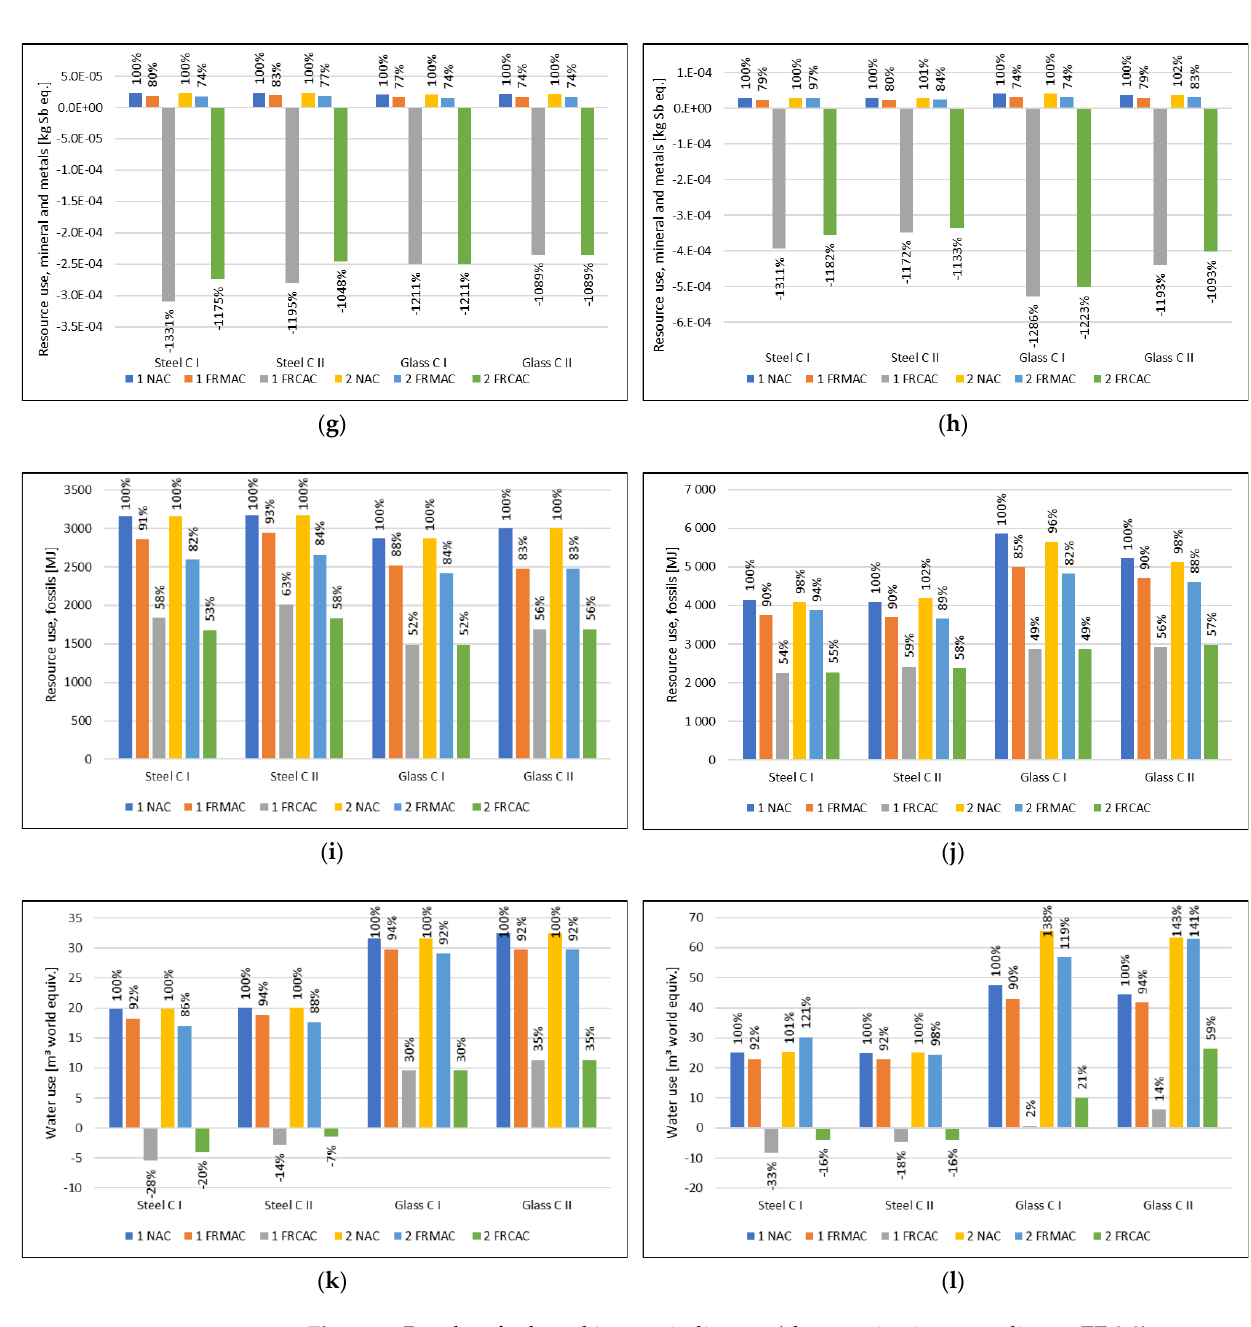
Figure 6. Results of selected impact indicators (characterization according to EF 3.0), concrete slab designed according to load-bearing capacity ( a , c , e , g , i , k ) and the serviceability limit state ( b , d , f , h , j , l ); design scenario using (1) the compensation by varying thickness of slab or (2) the compensation by varying reinforcement level; ( a , b ) ozone depletion (ODP), ( c , d ) ecotoxicity, freshwater total (ETP), ( e , f ) eutrophication, freshwater (EP), ( g , h ) resource use, mineral and metals (AD-min.), ( i , j ) resource use, fossils (ADP-fos.), ( k , l ) water use (WDP).